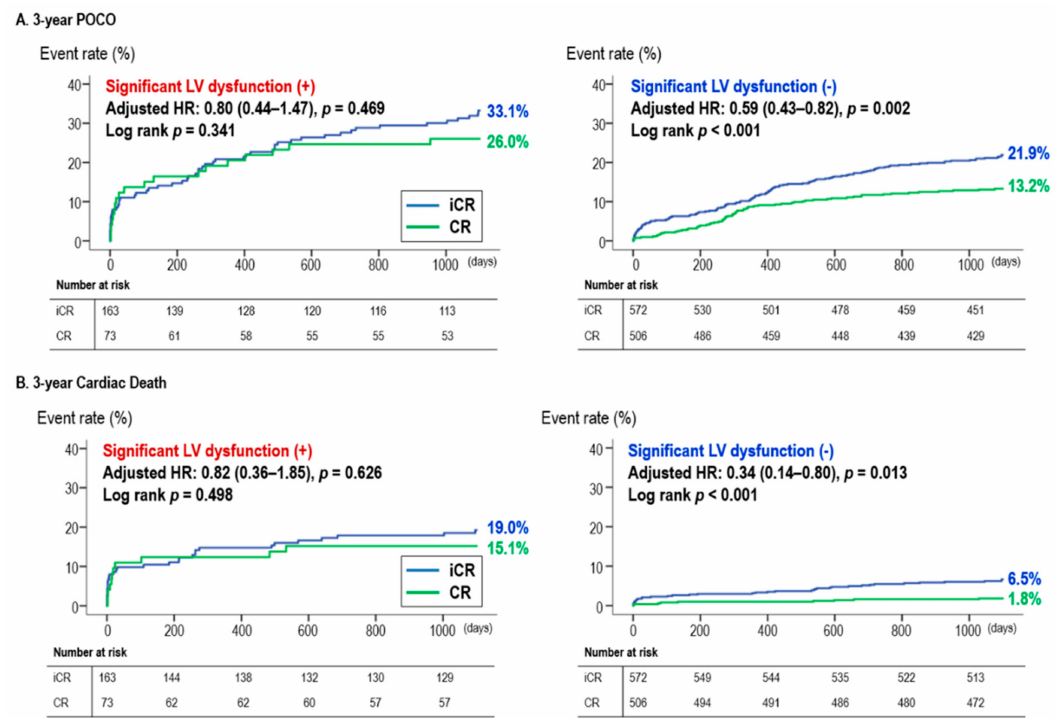
Figure 3. Survival curves during the three-year follow up period according to the presence of LV dysfunction: (A) three-year POCO and (B) three-year cardiac death. Abbreviations: CR, complete revascularization; HR, hazard ratio; iCR, incomplete revascularization; LVEF, left ventricular ejection fraction; POCO, patient oriented composite outcome.